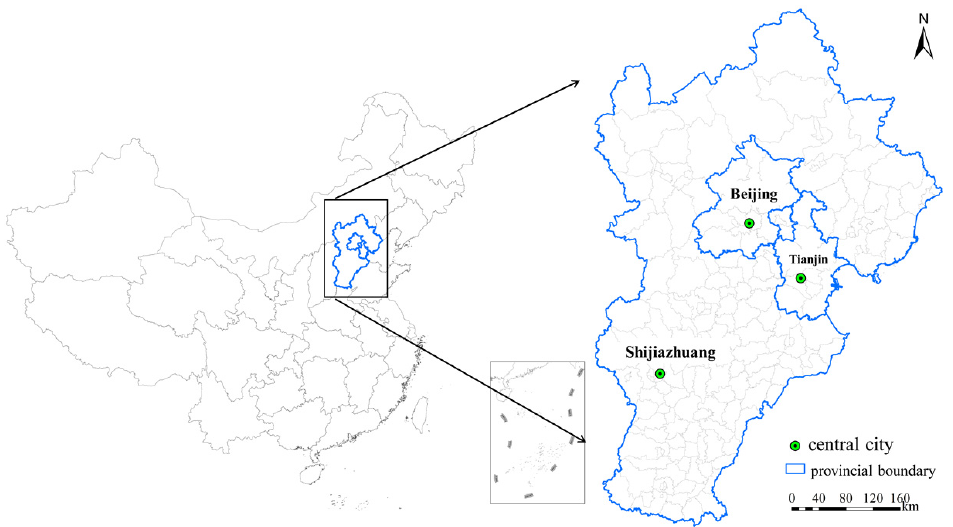
Figure 1. The study